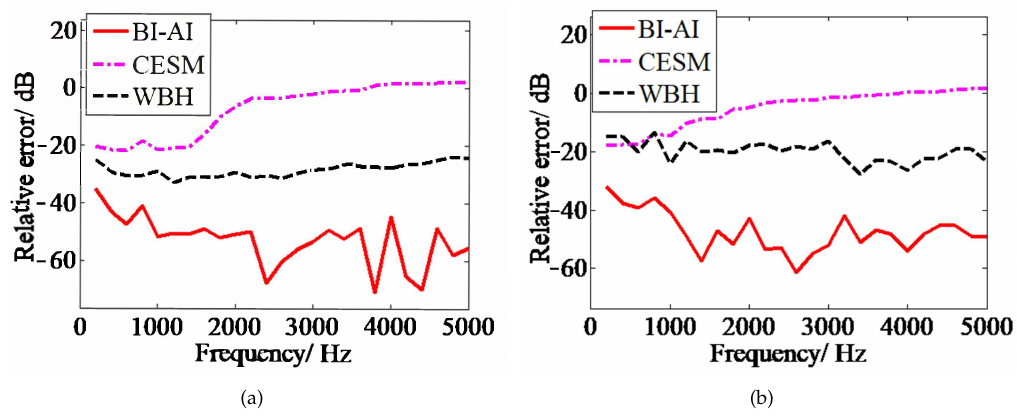
Figure 3. The relative error of reconstructed sound field for three acoustical holography methods including CESM, WBH, and BI-AI at frequencies of 200 Hz to 5000 Hz: ( a ) monopole sound source with unitary strength; ( b ) two coherent, in-phase monopole sound sources with strength of 1 and